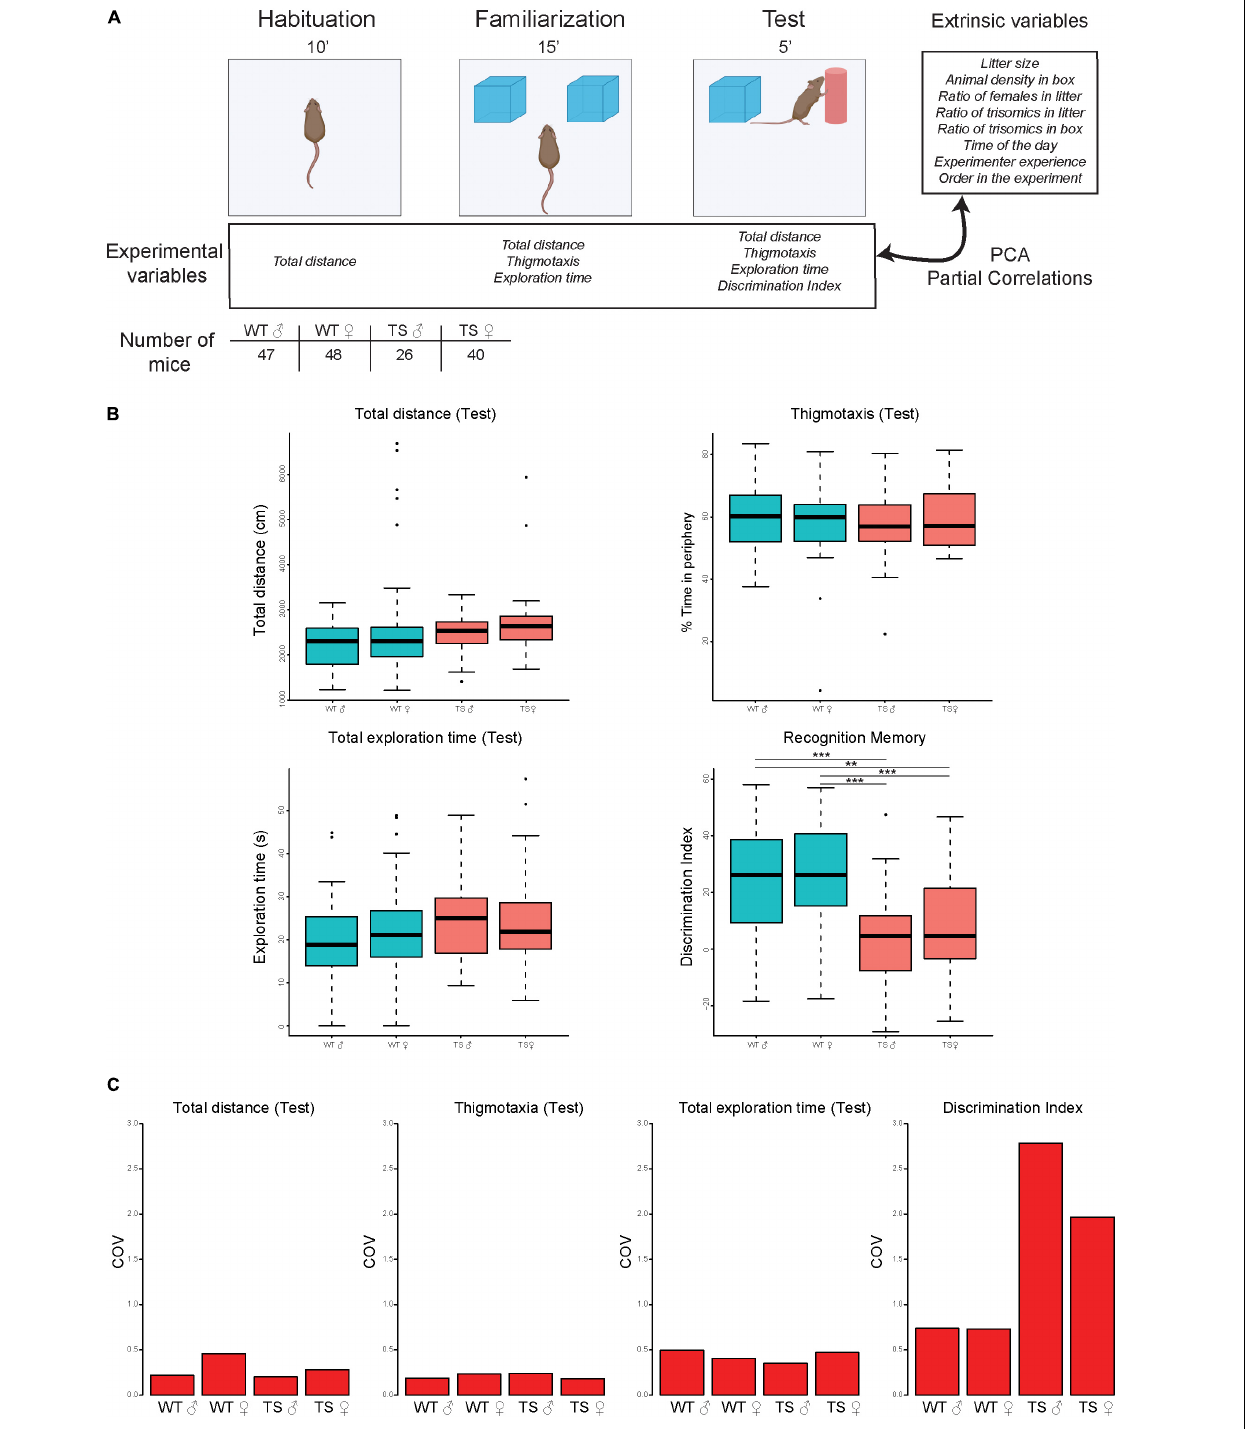
Frontiers in Behavioral Neuroscience |